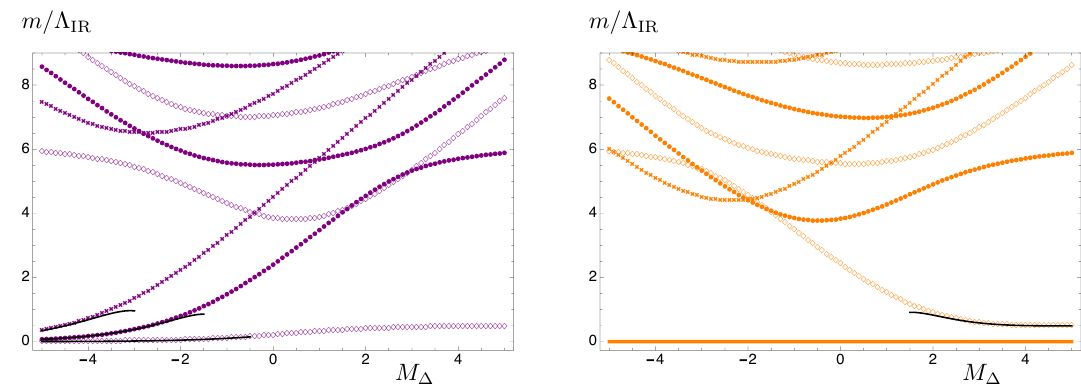
Figure 8 . Toy model. Fermionic spectrum as a function of M ∆ = M ∗ − M Ψ for r ∗ = 1 and ∆ R = 1 . 51 , 2 . 5 , 4 (diamonds, dots, crosses). The left and right panels correspond to imposing (+) and ( − ) IR boundary conditions, respectively. All plots are normalised to the IR scale Λ IR . The solid line in the right panel indicates the presence of a massless state. Rather than using the analytic expressions, we found it convenient to use the same numerical procedure in extracting the spectrum as for Models I and II, and in so doing we used the UV cutoff r 2 = 15 . Finally, the black lines